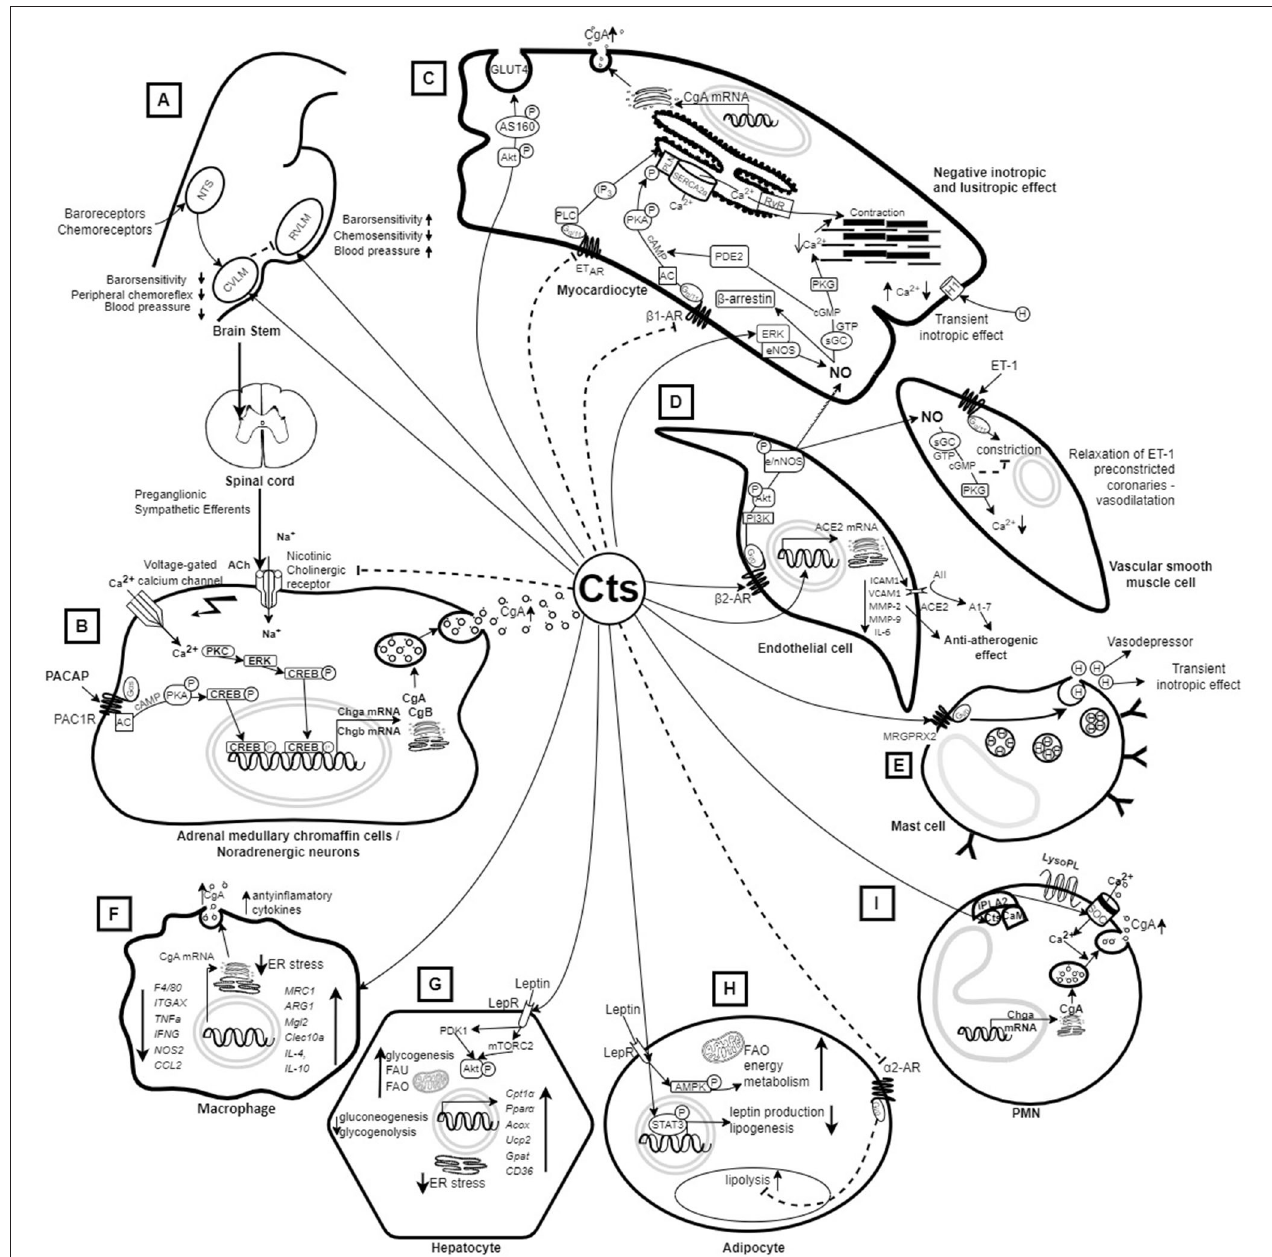
FIGURE 1 | Mechanism of action of catestatin based on in vitro and in vivo animal studies. (A) Injection of Cts into the CVLM or the central amygdala (not shown) of rats decreases sympathetic barosensitivity and attenuates peripheral chemoreflex with consequent hypotension. On the other hand, injection of Cts into the RVLM increases barosensitivity and attenuates chemosensitivity with consequent elevation of blood pressure (14). (B) Cts inhibits CA release by binding to nicotinic acetylcholine receptors that block Na + uptake (15) as well as due to PACAP stimulation (13). (C) Cts inhibits the PKA/PLN signaling pathway and induces NO synthesis in myocardiocytes, and the released NO reduces cellular Ca 2 + , resulting in decreased cardiac contractility (16) and relaxation of ET-1 preconstricted coronaries (17). Cts also induces glucose uptake and Glut4 translocation (18). (D) Cts induces NO synthesis from endothelial cells, and activates ACE2, which has an anti-atherogenic effect (15, 16, 19). (E) Cts induces histamine release leading to vasodepression and transient inotropic effect in myocardiocytes (16). (F) Treatment with Cts results in polarization of macrophages toward an anti-inflammatory phenotype (20). Macrophages also produce Cts (21). (G) Cts up-regulates genes promoting fatty acid oxidation (22) and enhances insulin-induced Akt phosphorylation, which helps in overcoming ER stress and achieving insulin sensitivity (23). (H) Cts promotes lipid flux from adipose tissue toward the liver and lowers plasma leptin in Chga-KO mice leading to resensitization of leptin receptors (22). (I) PMNs are able to produce and secrete CgA-derived peptides, including Cts, which may penetrate into PMNs and activate the release of innate immune factors (24). A1-7, Angiotensin 1-7; AII, Angiotensin II; AC, Adenylyl cyclase; ACE2, activates angiotensin-converting enzyme-2; Ach, acetylcholine; Acox1, acyl-CoA oxidase 1;